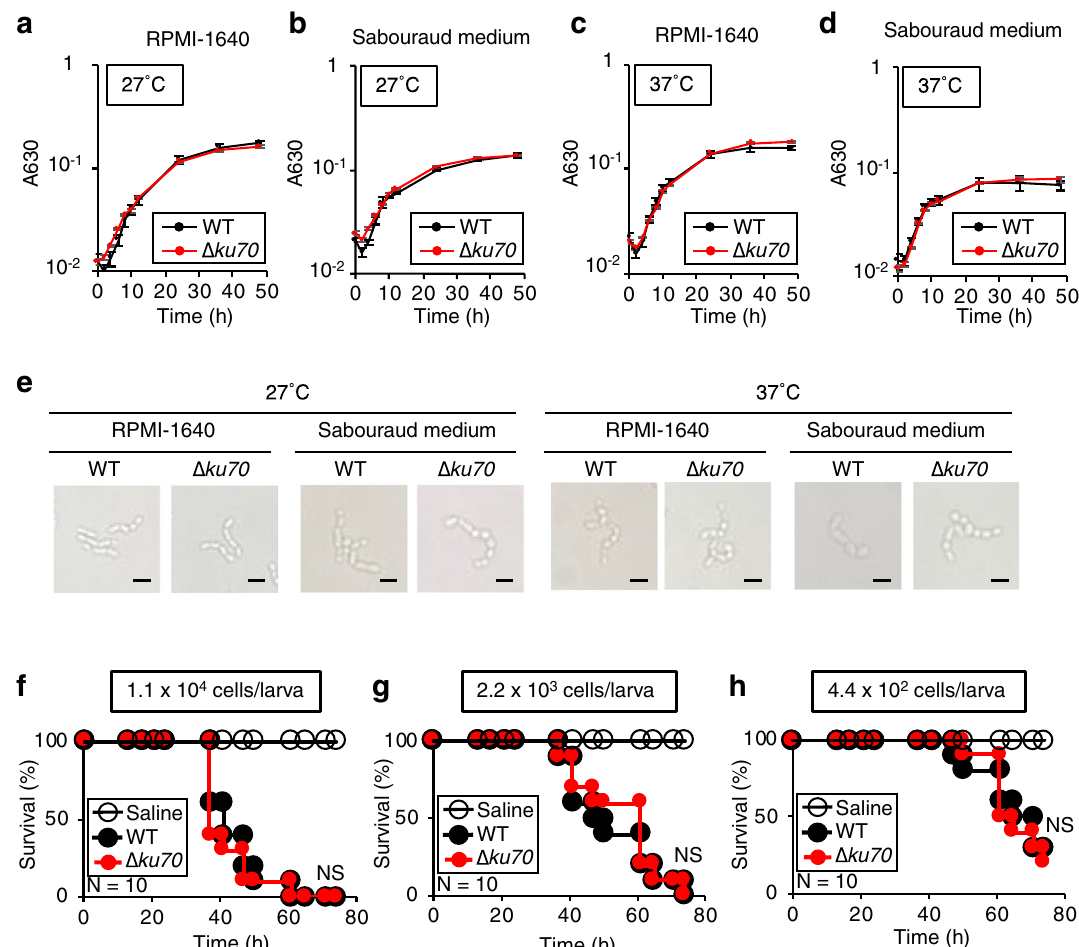
Figure 3. Effects of ku70 gene-deficiency in the T. asahii MPU129 mutant on growth, morphology, and pathogenicity against silkworms. ( a–d ) The wild-type (MPU129) and ku70 gene-deficient mutant were inoculated on RPMI-1640 medium and Sabouraud medium and incubated at 27 °C or 37 °C. Absorbance 630 nm of the culture was monitored. Data are shown as means ± standard error of the mean (SEM). ( e ) The wild-type (MPU129) and ku70 gene-deficient mutant were incubated at 2 days after inoculation and observed with a microscope. ( f – h ) Saline, T. asahii MPU129 (WT), or the ku70 gene-deficient mutant (∆ ku70 ) [1.1 × 10 4 cells/larva ( f ), 2.2 × 10 3 cells/larva ( g ), 4.4 × 10 2 cells/larva ( h )] were injected into the silkworm hemolymph and incubated at 37 °C. The survival of the silkworms was monitored for 74 h. The significance of differences between groups in silkworm infection experiments was calculated by the log-rank test based on the curves by the Kaplan–Meier method. NS Not significant ( P > 0.05). n =